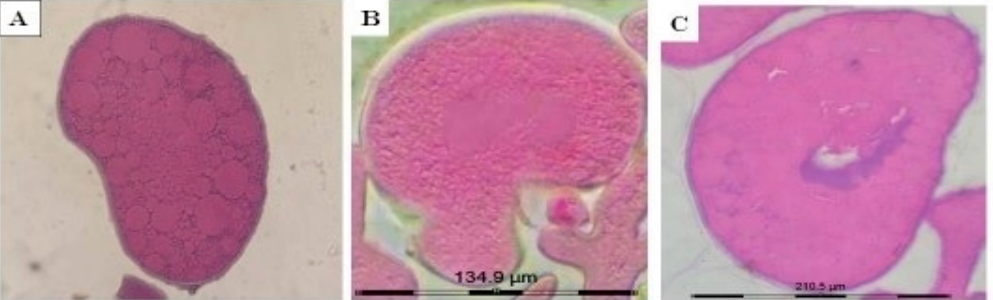
Figure 2. Microphotograph of immunoperoxidase labelling with anti-COX1 in R. annulatus tick ovaries. ( A ): Oocyte of ovary of control tick showing intact membrane, yolk droplets and cytoplasm; with no localization of COX-1enzyme; ( B ): Oocyte of ovary of ticks treated with flumethrin (90 ppm) showing irregular shaped oocyte and disrupted yolk droplets with no localization of COX-1enzyme; ( C ): Oocyte of ovary of tick treated with terpenoid subfraction of A. nilagirica (40%) showing degeneration of nuclear region and disrupted yolk granules with no localization of COX-1 enzyme.